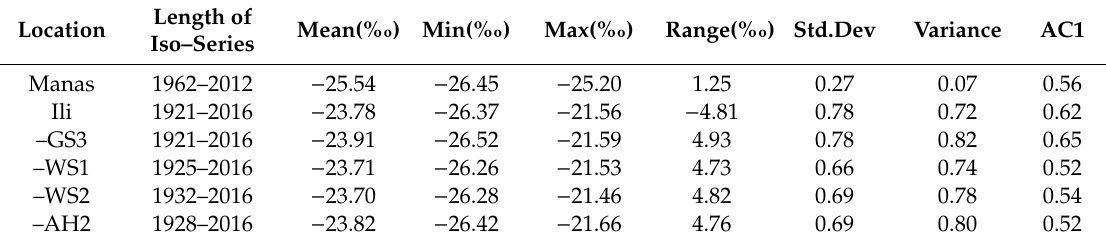
Table 6. Statistics of the δ 13 C time series of Ili and Manas.